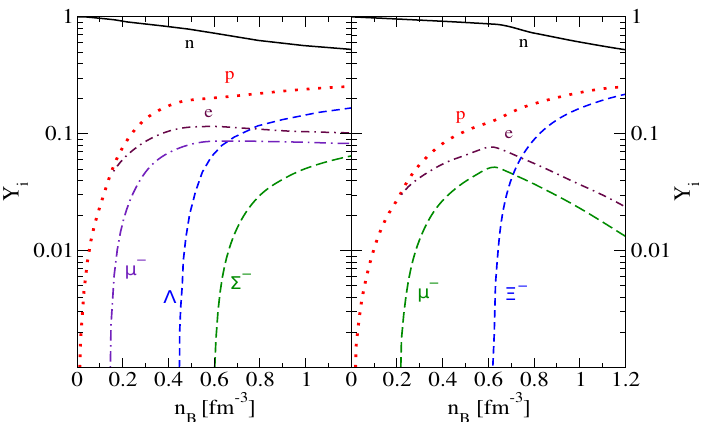
Figure 2. Particle composition (Y i ) as a function of the baryonic density for the Chiral SU(3) model , adapt from Ref. [57], ( left panel ) and RHF model ( right panel ) by Katayama (adapt from Ref. [101]). See text for details.